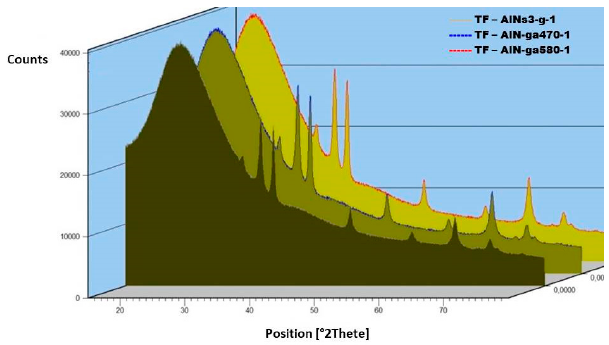
Figure 6. AlN pre RX analysis before and after two annealing steps.